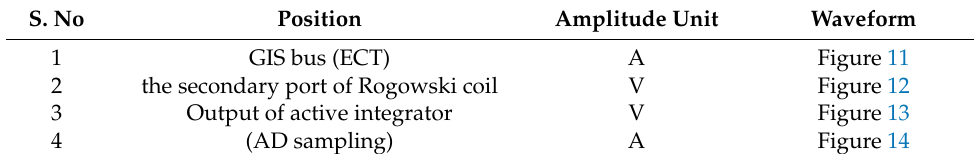
Table 6. Transient VFTC at different ECT component points (the whole process).